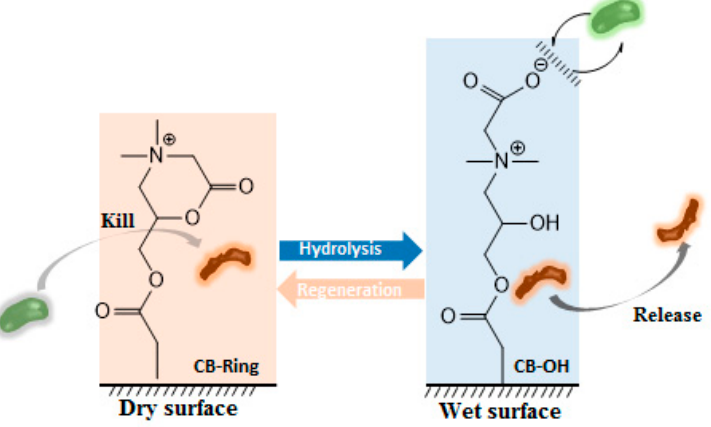
Figure 5. Mechanism of the transition between attack function (CB-ring, killing bacteria) and defense function (CB–OH resists and releases bacteria) (adapted from [135]).